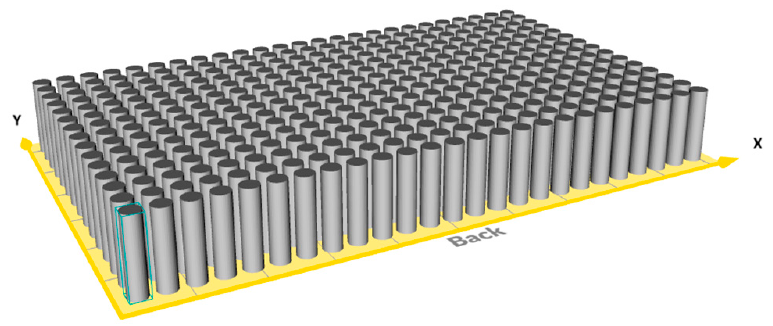
Figure 3. Components (375 in number) of CG1 arranged on the building platform.